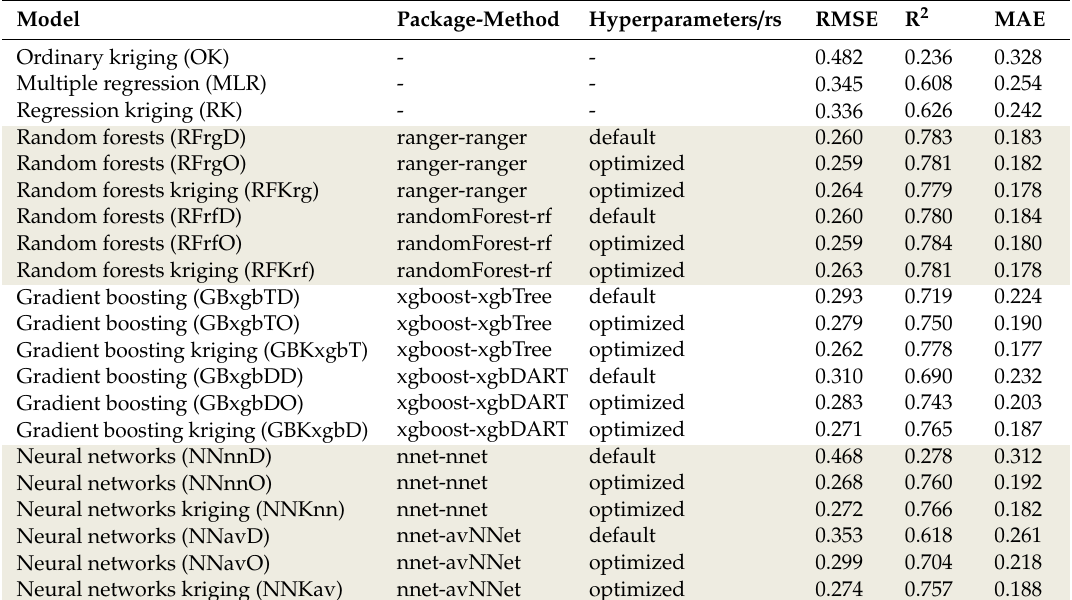
Table 10. Prediction results for